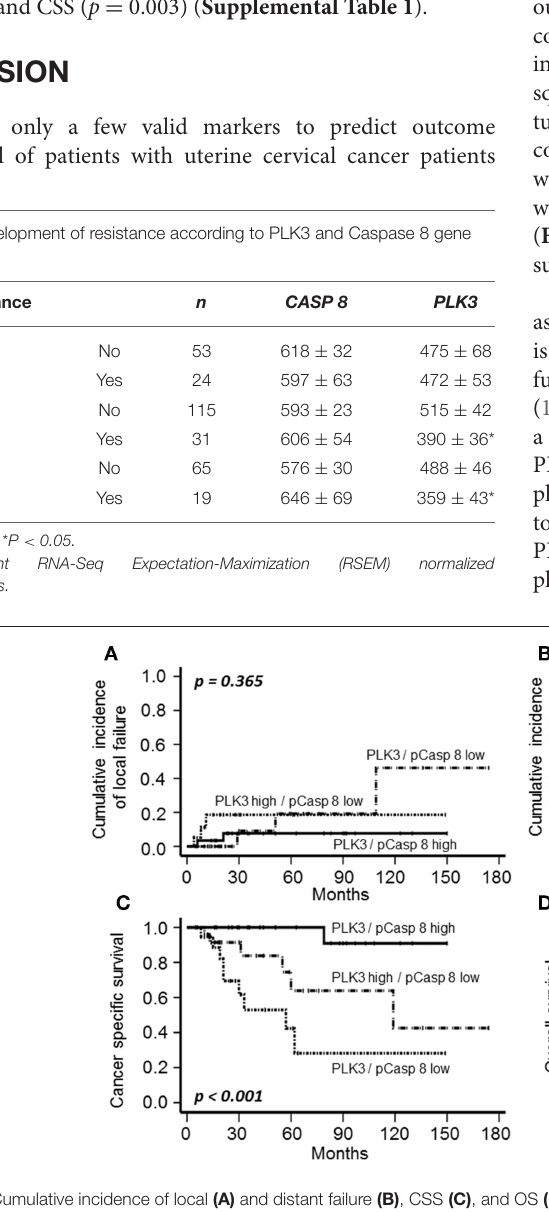
Frontiers in Oncology |